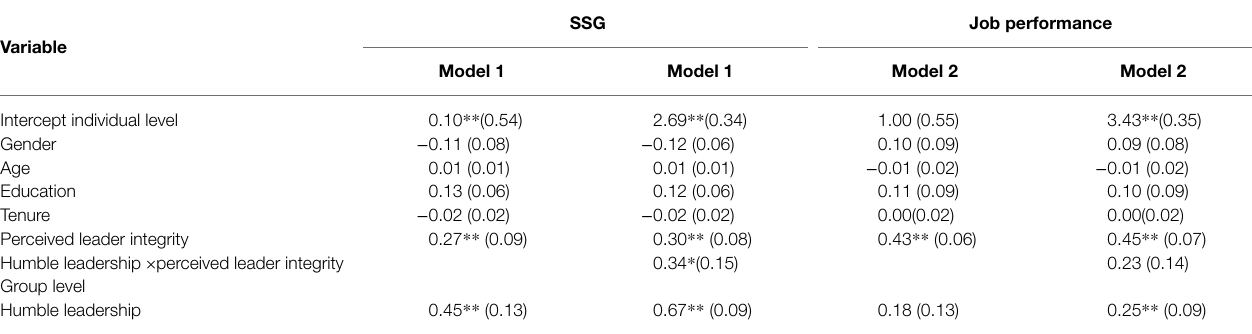
TABLE 3 | The moderating effect of leader integrity.